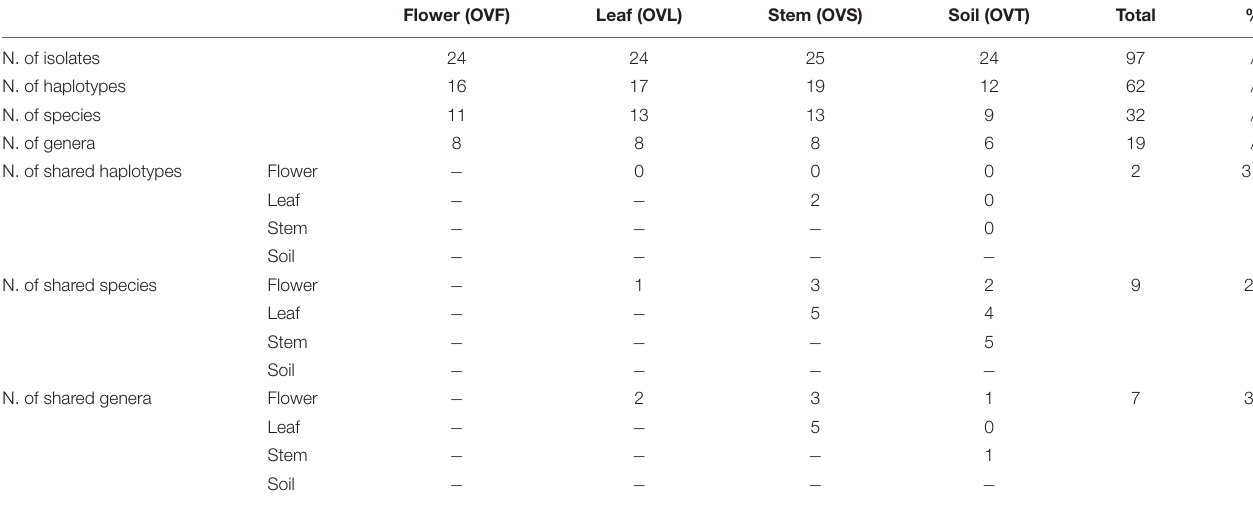
TABLE 4 | Distribution of bacterial haplotypes, species, and genera detected in the four districts of O. vulgare plant.